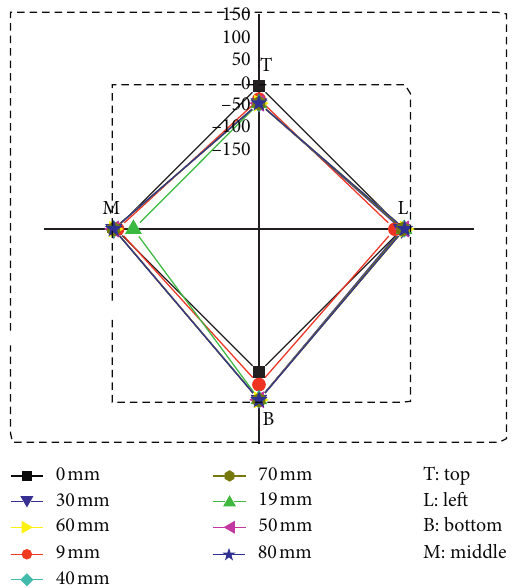
Figure 21: Intersection position of structure and ground fissure cabin 2